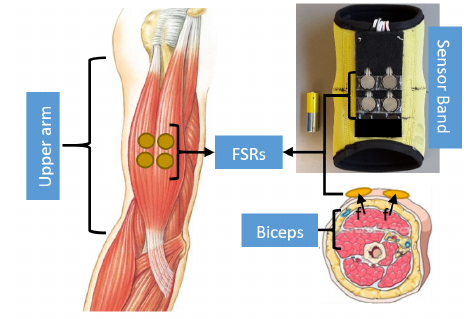
Figure 1: Sensor band working principle and it’s place- ment on the upper